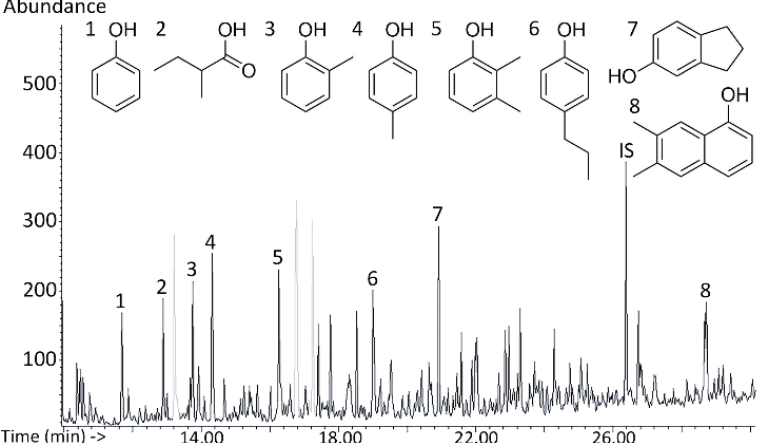
Figure 1. Chromatogram of the oil from experiment SW1-kraft-360. Peaks from impurities in the solvent are in grey. Internal standard (IS) is hexadecane.